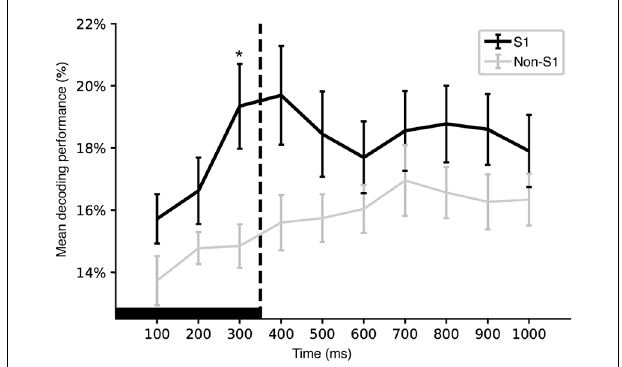
FIGURE 6 | Time evolution of mean decoding performance. Plot of the evolution of the mean decoding performance for individual S1 and non-S1 neurons across integration time windows of increasing duration. The integration time is indicated along the x -axis. Whiskers indicate standard error of the mean. A star indicates a statistically significant difference for that time window ( p < 0.05, Mann Whitney U test). Note that the y -axis starts at chance level (12.5%). Solid black horizontal bar indicates the duration of the longest stimulation pattern, the dashed line indicates the time of its